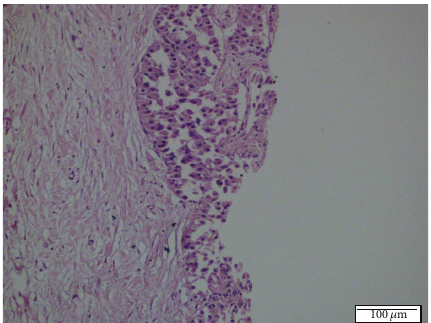
Figure 2: Histopathologic appearance of tumoral lesion in first Tru- Cut biopsy. Microscopically, a tumor consists of epithelial cells with round, basophilic, uniform nucleus, inconspicuous nucleoli, and pale eosinophilic granulated cytoplasm. The architectural pattern was trabecular, ribbonlike, and partly acinar. No significant cyto- logic atypia, mitosis, and necrosis were present. H.E. × 200.